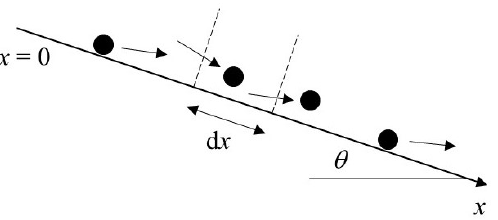
Figure 2. Definition diagram of surface inclined at angle θ and con- trol volume with edge length d x through which particles